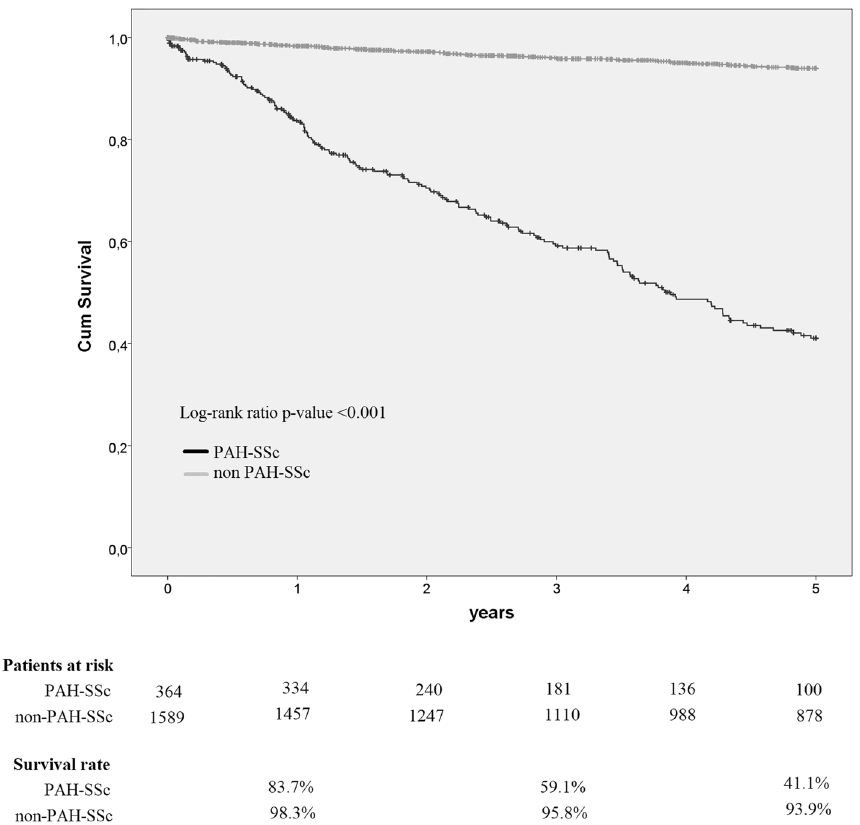
Figure 1. Kaplan–Meier analysis of transplant-free survival in PAH-SSc patients compared with